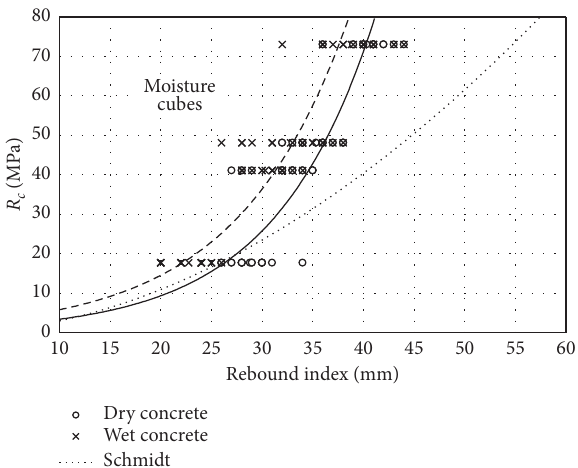
Figure 6: Calibration curve for dry and saturated cubes. Con- tinuous line: dry cubes; dashed line: saturated cubes; dotted bold: Schmidt curve. Calibration curve: R c � e a RI ; RI � rebound index; a ∈ [0.11, 0.12]; R 2 � 0.91. Inside any dataset, C.o.V. ≤ 9%, dry; C.o.V. ≤ 12%, saturated.